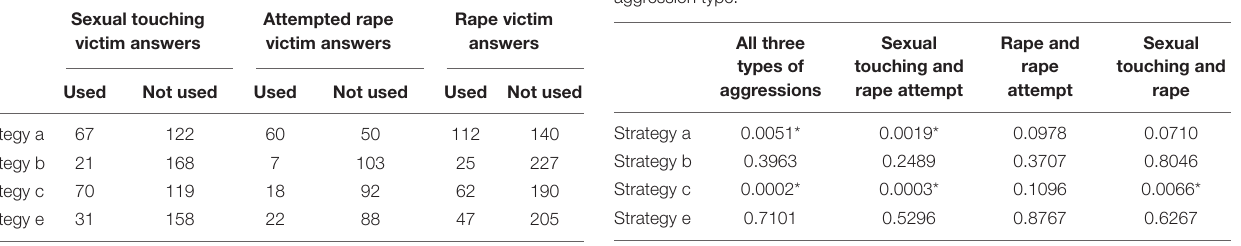
TABLE 5 | Numbers used in the single strategy centered contingency tables. TABLE 6 | p -Values of difference in presence of strategies depending on aggression